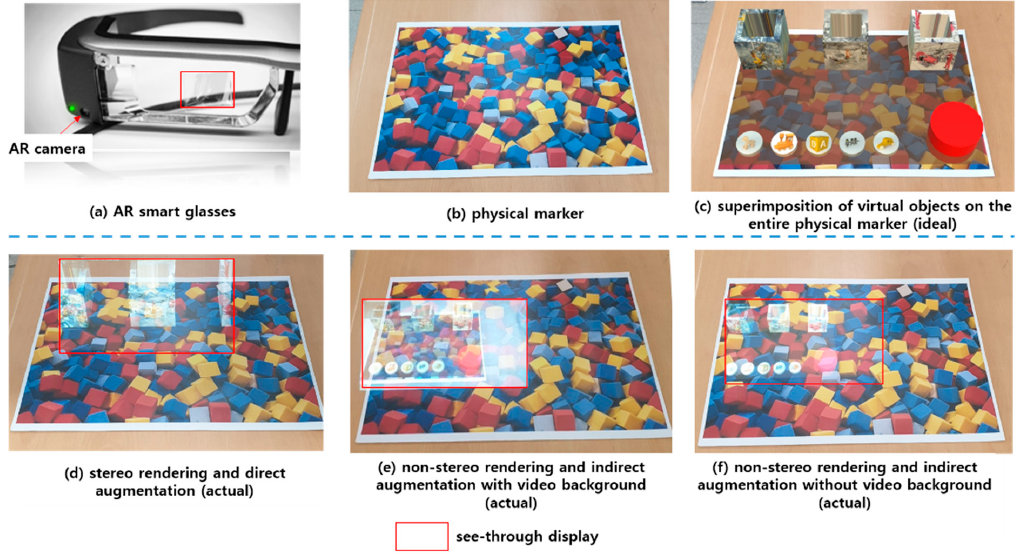
Figure 2. Visual augmentation concerning visual contexts in the real AR smart glasses.